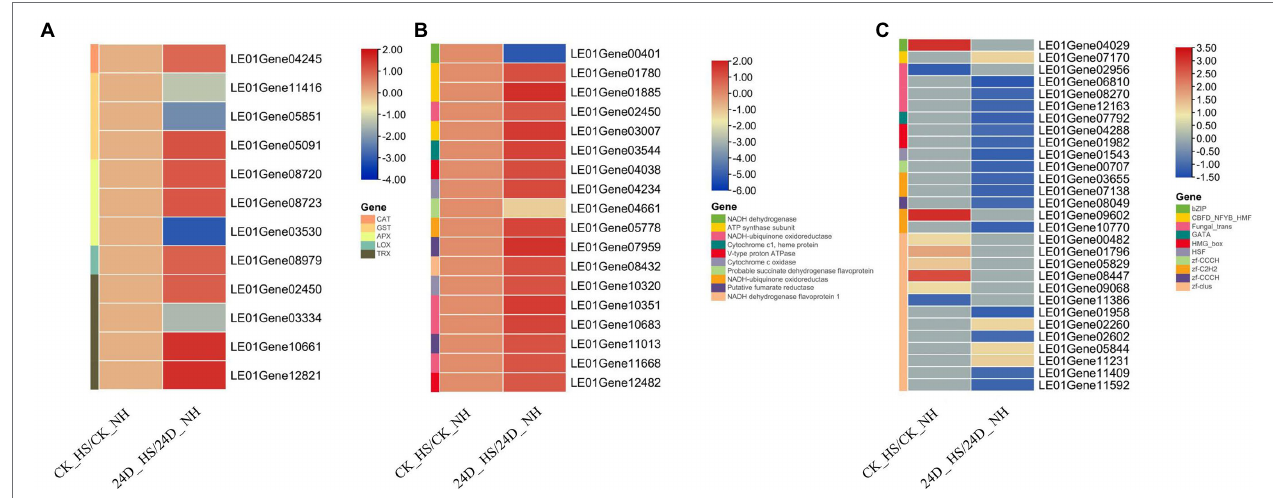
FIGURE 2 | Heat map diagram showing CK_HS/CK_NH and 24D_ HS/24D_ NH related differentially expressed genes (DEGs). (A) Effects of 2,4-D and heat stress on the expression of antioxidant genes. (B) Effects of 2,4-D and heat stress on the expression of oxidative phosphorylation related genes. (C) Effects of 2,4-D and heat stress on the expression of transcription factors. Genes with no differential expression are indicated by 0 in the